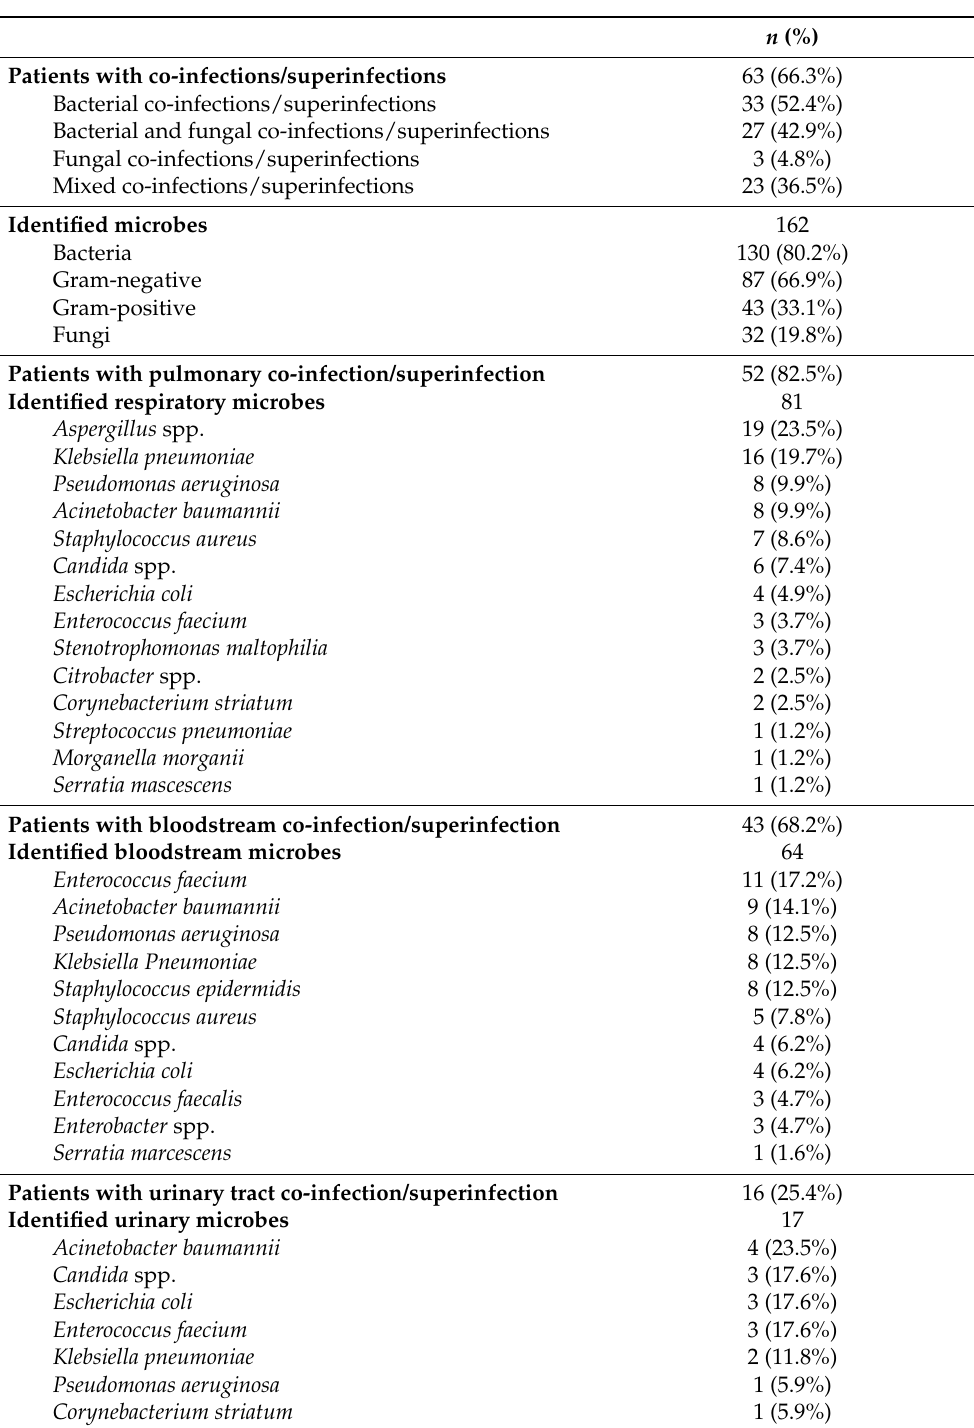
Table 2. Microbiology isolated by type of